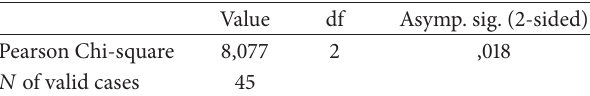
Figure 3: Microscopy images. (a) Gram-positive rods 100x oil. (b) Gram-negative bacilli 100x oil. (c) Gram-positive cocci and Gram-negative bacilli 100x oil. Table 2: Chi-square test.